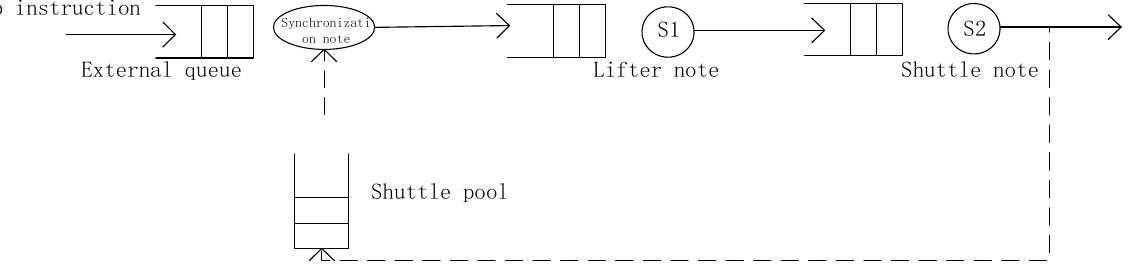
Figure 6. Semi-open-loop queuing network using the serial strategy .